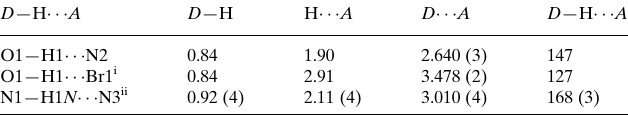
Hydrogen-bond geometry (A˚ , (cid:2)